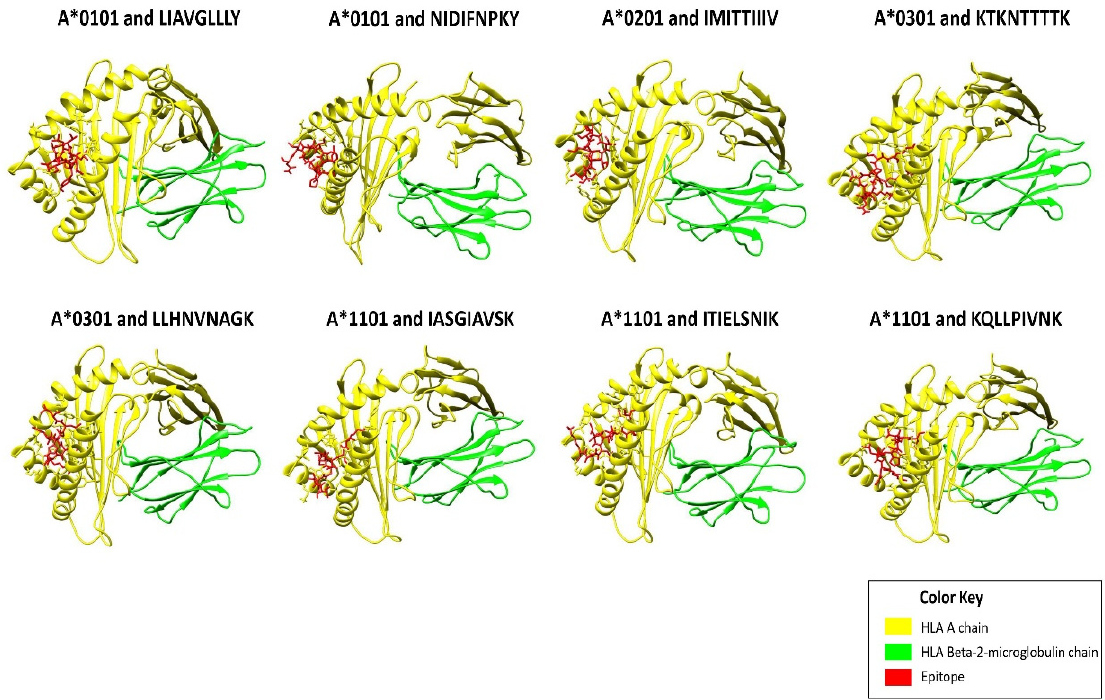
Figure 1. Figure showing structural interactions between the prioritized HLA I epitopes (colored in red) and cognate HLA I chains (colored in yellow and green). Out of all the HLA I epitopes, KTKNTTTTK (from the G glycoprotein) showed the best docking score ( − 113.8) with cognate HLA I molecule HLA-A*0301, followed by epitope LLHNVNAGK ( − 104.2) of the F glycoprotein with HLA-A*0301, and so on. It can be observed that all the epitopes fit comfortably inside the binding groove of the HLA molecule and thus are projected to interact strongly with their cognate HLA I allele.